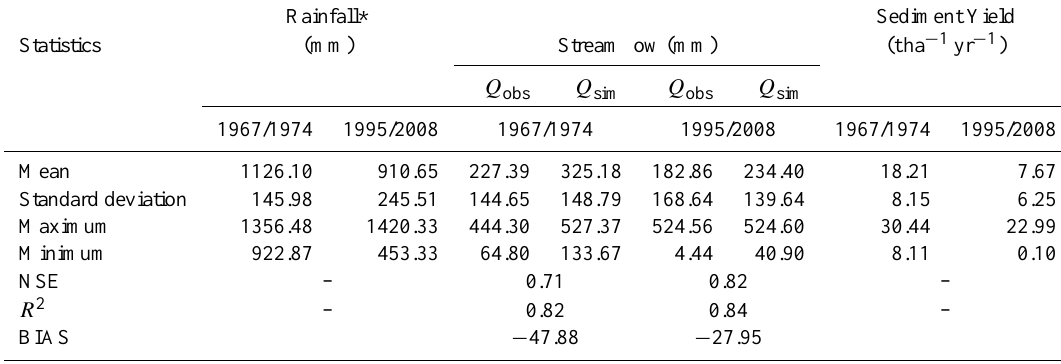
Table 1. Descriptive statistics of measured and simulated monthly streamflow and sediment in the Tapacurá River basin. Rainfall*